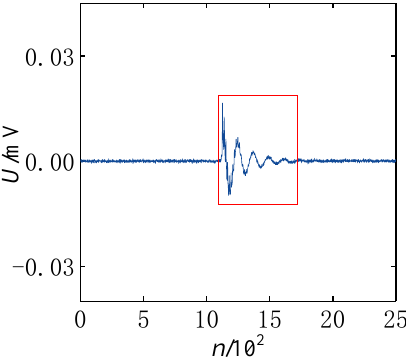
Figure 4. Time domain signals of discharge pulse.